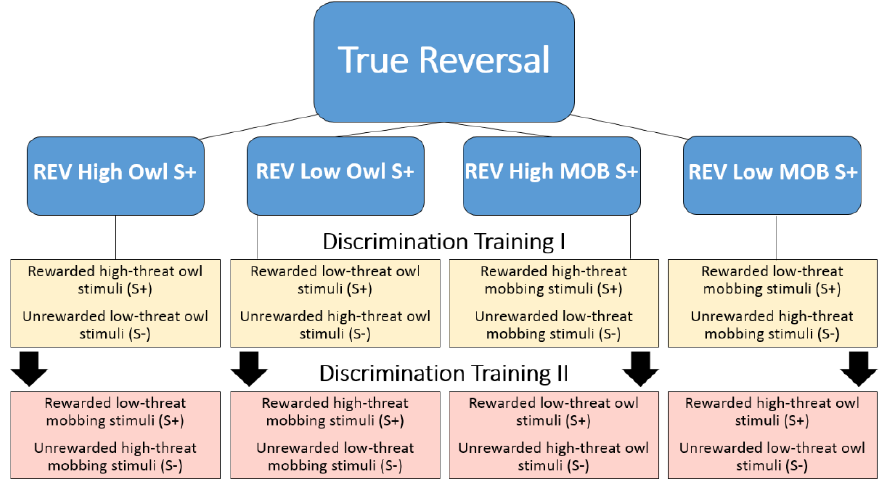
Schematic of the Stimulus Types and Reward Contingencies for Discrimination Training I and Discrimination Training II for the Four (4) Subgroups of the True Reversal